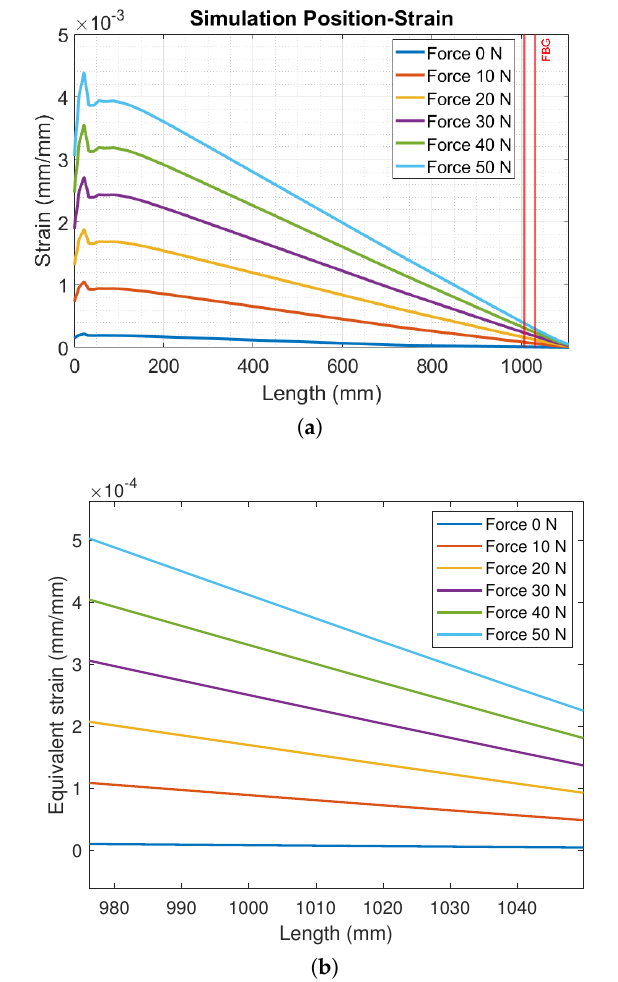
Figure 6. ( a ) Strain variation over the length of the virtual beam due to different loadings. ( b ) Strain variation in the FBG region for different loading